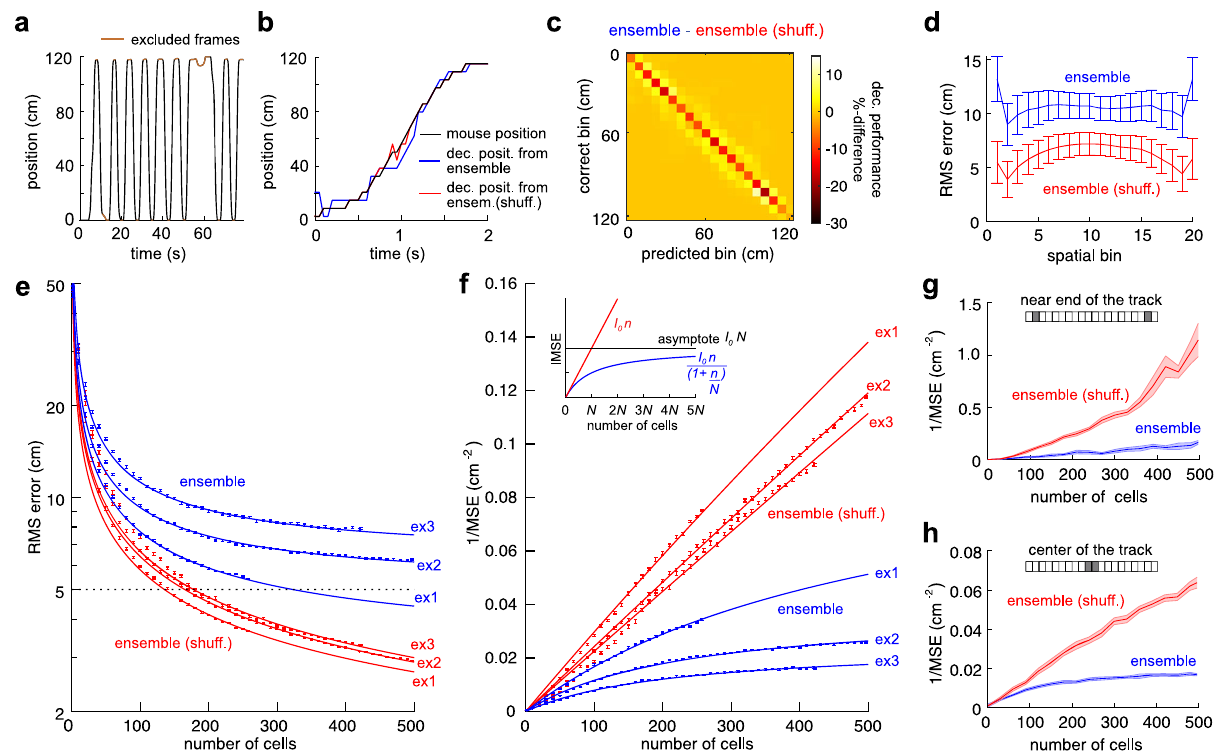
Fig. 2 Noise correlation limits the spatial information encoded in the neural ensemble. a Position during running behavior (black). Each whole run through the track is considered a separate trial. b Example of one trial showing the actual (black) and decoded locations of the mouse using ensemble data (blue) and trial-shuf fl ed noise correlation-free data (red). c Percent difference between the decoders ’ confusion matrices (unmodi fi ed data minus shuf fl ed data) for rightward runs. For all confusion matrices, see Suppl. Figure 4. d The root mean squared (RMS) error between predicted and recorded positions of the mouse, for each spatial bin, for unmodi fi ed data (blue) and noise correlation-free data (red), averaged over all 110 sessions. Error bars are the 95% con fi dence intervals of mean values. e RMS error from a neural decoder using unmodi fi ed (blue) and noise correlation-free (red) data as a function of the number of cells. Each data point denotes an average of over 80 randomly chosen subsets of cells. The data shown are from three different sessions with three individual mice (all sessions are shown in Suppl. Fig. 7). Solid lines follow the parametric fi ts in f . Error bars represent SEM over the random subsets of neurons trained with half of the trials and tested with the other half. f Inverse mean squared error (IMSE) as a function of the number of cells included in the decoder. Solid lines show parametric fi ts to the function shown in the inset. Error bars shown are based on the same data as in e . Inset : Graphical representation of the IMSE(n) = I 0 n/(1 + n/N) function used to fi t the asymptotic behavior of the data. The parameter I 0 represents the linear slope at a small ensemble size. N is the ensemble size where the IMSE equals half the asymptotic value. The product of the two, I 0 N, is the asymptotic value of the IMSE (Suppl. Fig. 7). g IMSE computed for one session with animal 2022 for the two bins closest to the end of the track (ends excluded because of behavioral variability). The shaded area represents the 95% con fi dence intervals of mean values of the IMSE for the valid trials in the displayed spatial bins. h IMSE computed for one session with animal 2022 for the bins in the center of the track. The shaded area is as in g . Source data is provided as a Source Data fi